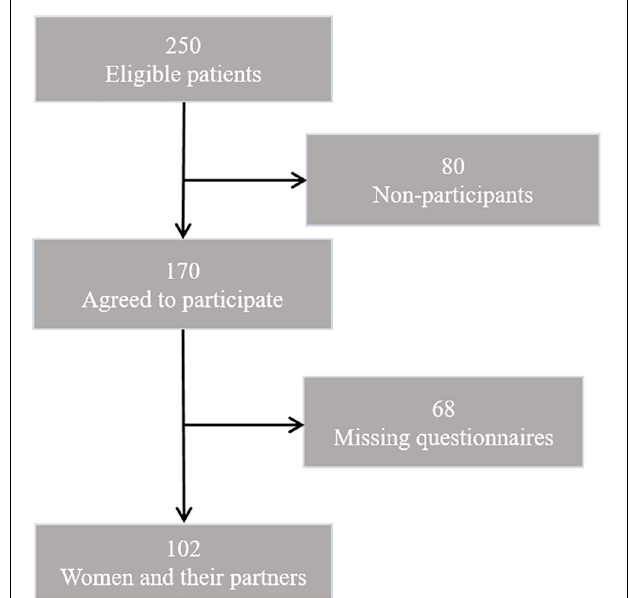
FIGURE 1 | Study sample recruitment.